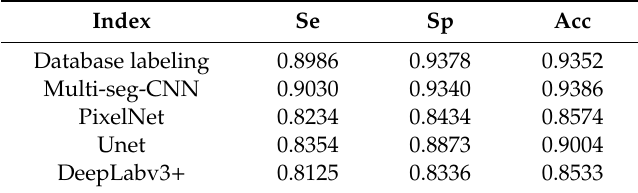
Table 4. Exudate segmentation accuracy by di ff erent networks.